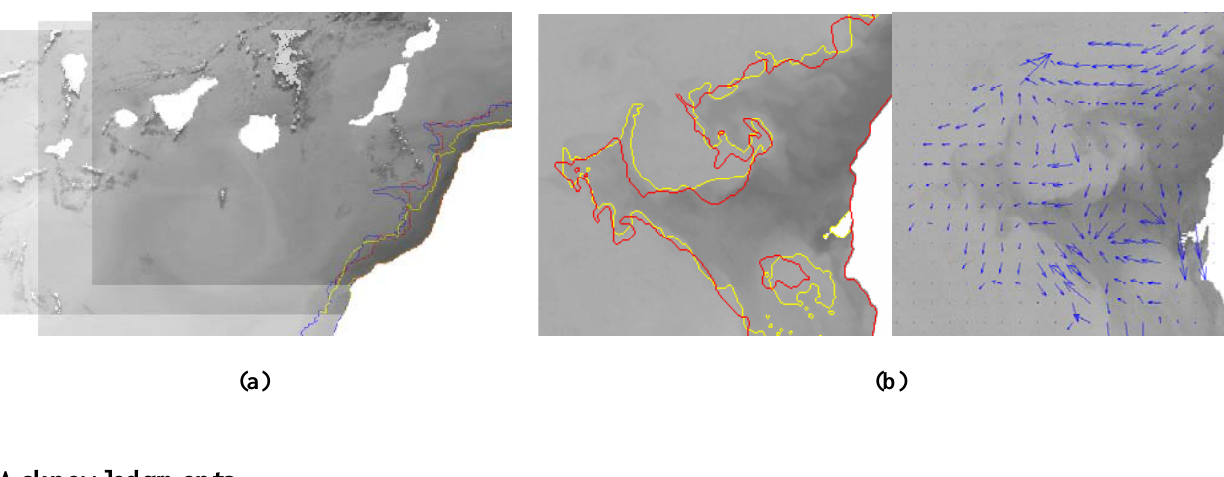
Figure 7. Results of satellite imagery registration technique applied to automatic structures tracking: (a) upwelling contours for AVHRR images of 15 (blue, 425x525), 16 (red, 350x450) and 17 (yellow, 400x600) August 2001. (b) Motion estimation for a pair of images of Cape Ghir of 9 (yellow) and 10 (red) November 2002